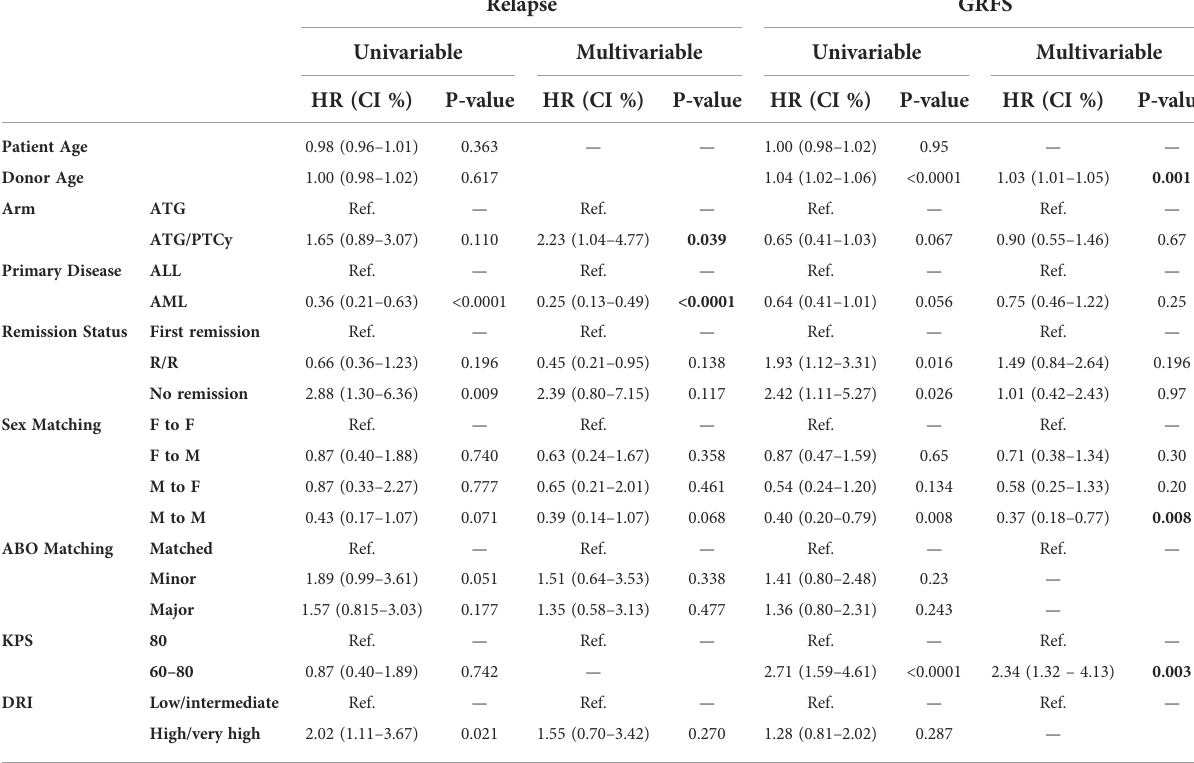
TABLE 3 Univariable and multivariable modeling for relapse incidence and GvHD-free relapse-free survival.